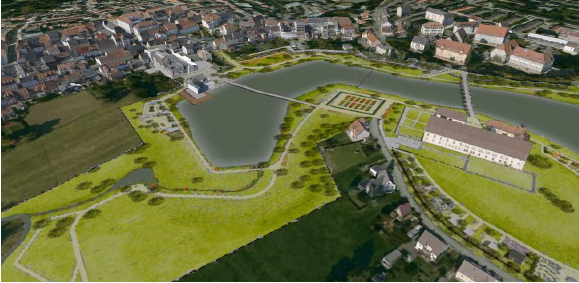
Figure 14. 3D-building model with design plan of a horticultural show